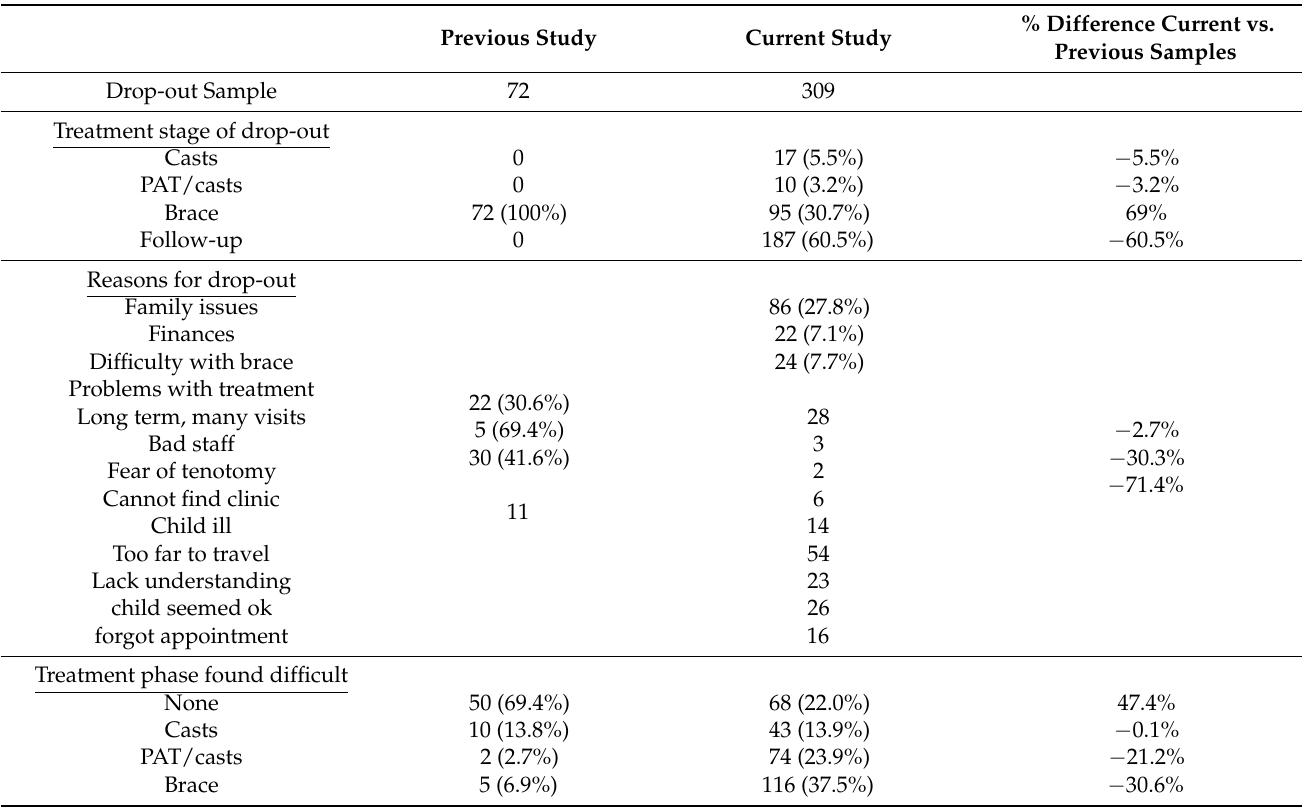
Table 2. Treatment stage and parents’ reasons for